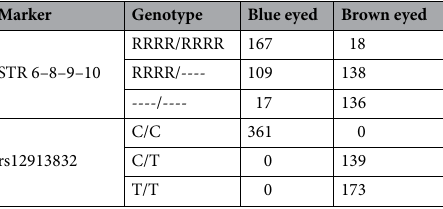
Table 4. The core haplotype RRRR of STR 6–8–9–10 in predicted blue and brown eye Europeans compared to rs12913832 genotypes in the same individuals. ---- indicates any haplotype not RRRR.